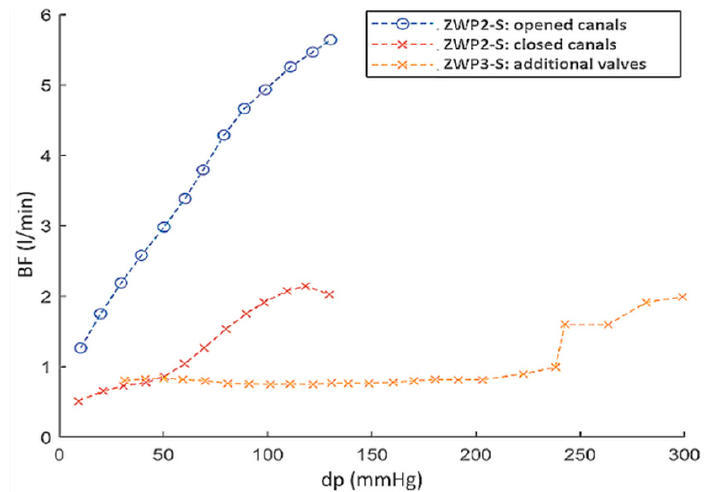
Figure 16. Comparison of backflows of various types of outflow valves (description in the text).